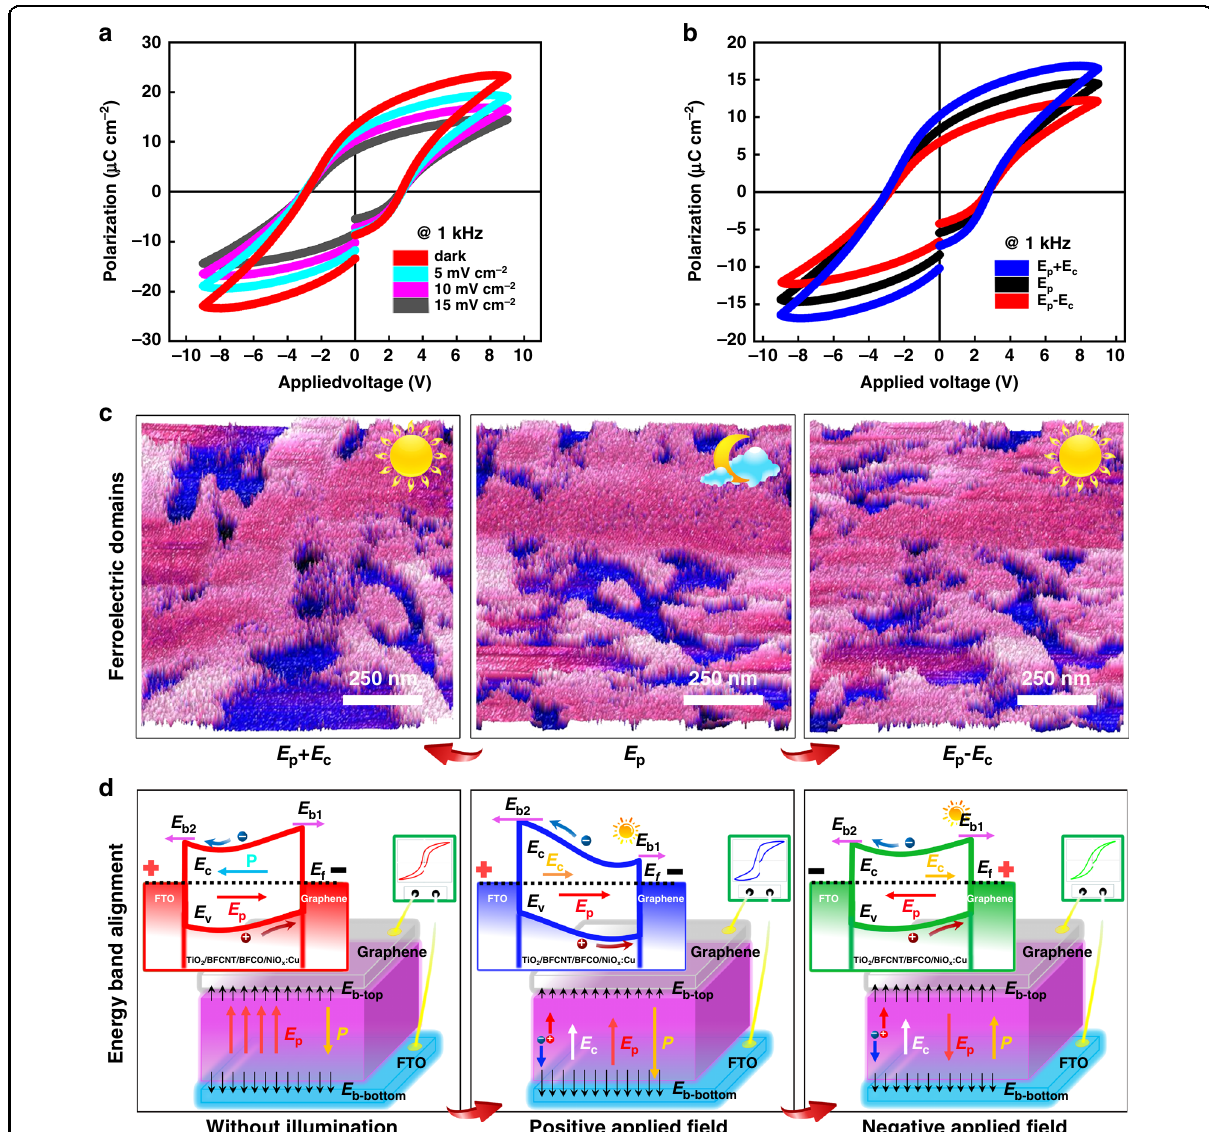
Fig. 4 Effect of illumination on ferroelectric polarization. a Changes of P-V loop with different power densities of the light source. b Effect of illumination and fi eld direction on ferroelectricity of BFCNT/BFCO heterojunction. c Evolution of ferroelectric domains under different conditions. d Schematic of both energy band alignment and the corresponding changes of the built-in polarization with and without